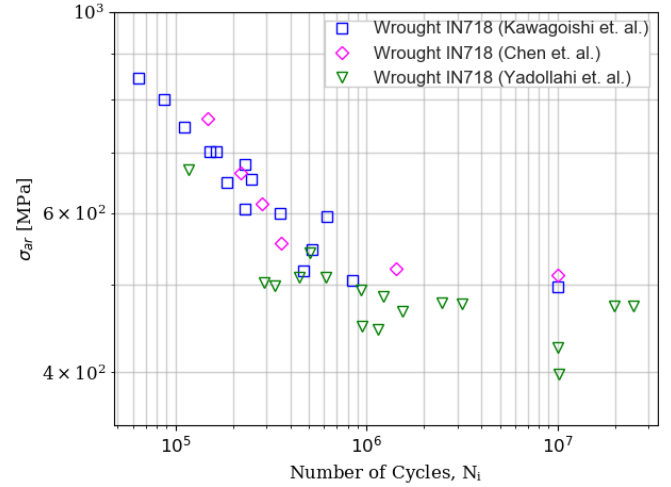
Figure 27: Compilation of rotary-bending-fatigue data for wrought IN718 [65,68,69].